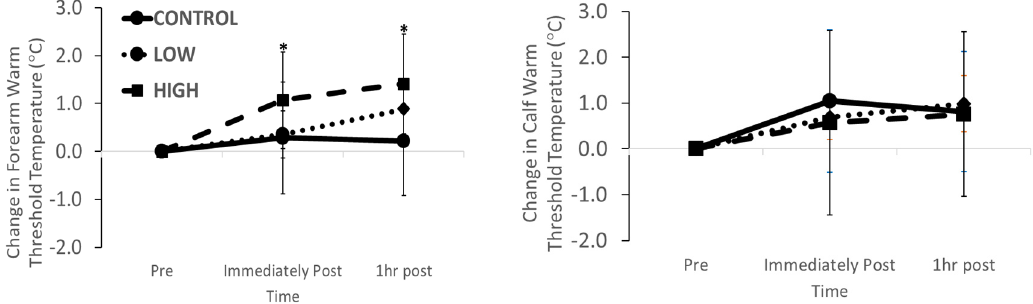
Figure 1. Changes in forearm and calf skin warm thermal sensitivity immediately and 1 hr after LOW and HIGH exercise and CONTROL * p < 0.05 vs. LOW and CONTROL.